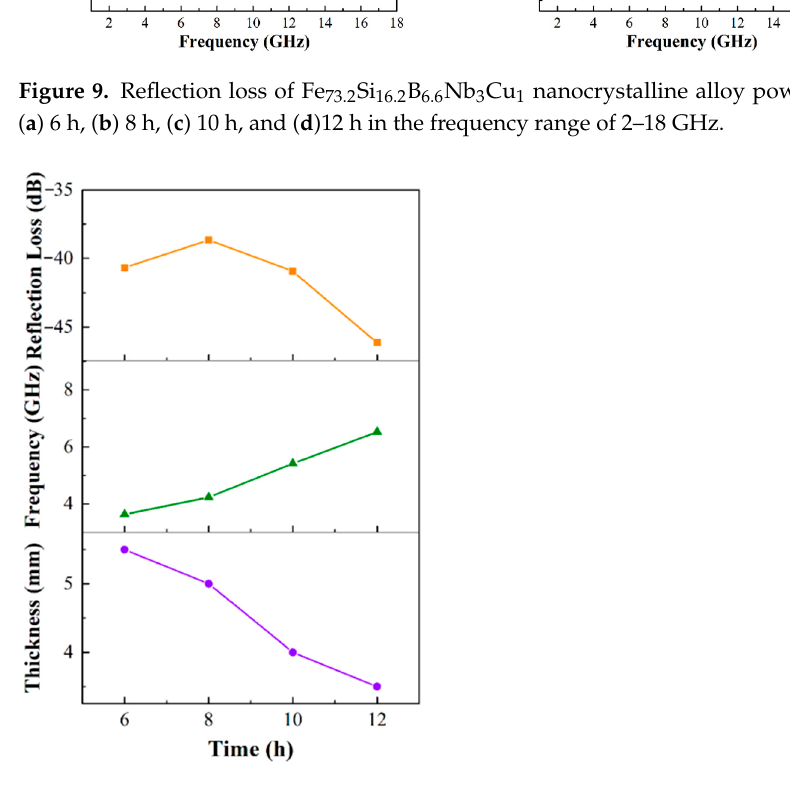
Figure 10. Curves of the minimum reflection loss Rl min , the best matching frequency f Rlmin , and the best matching thickness d Rlmin of Fe 73.2 Si 16.2 B 6.6 Nb 3 Cu 1 nanocrystalline alloy powder as a function of ball milling time.